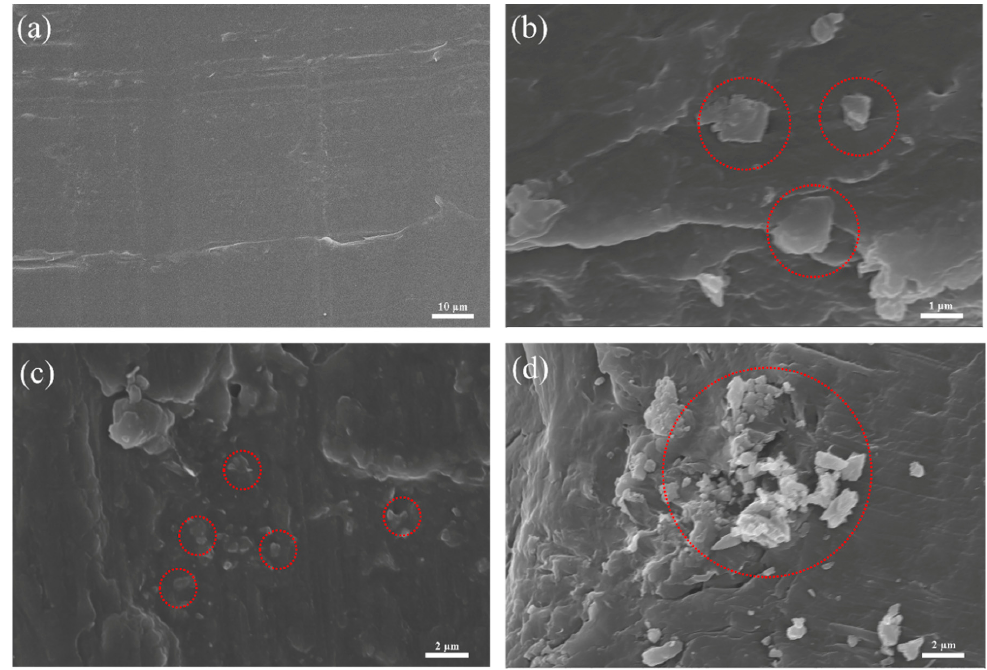
Figure 12. Scanning electron microscopy (SEM) micrographs of pure PA66 ( a ), 0.1% EG/PA66 ( b ), 0.3% EG/PA66 ( c ), and 0.5% EG/PA66 ( d ) fracture surfaces.